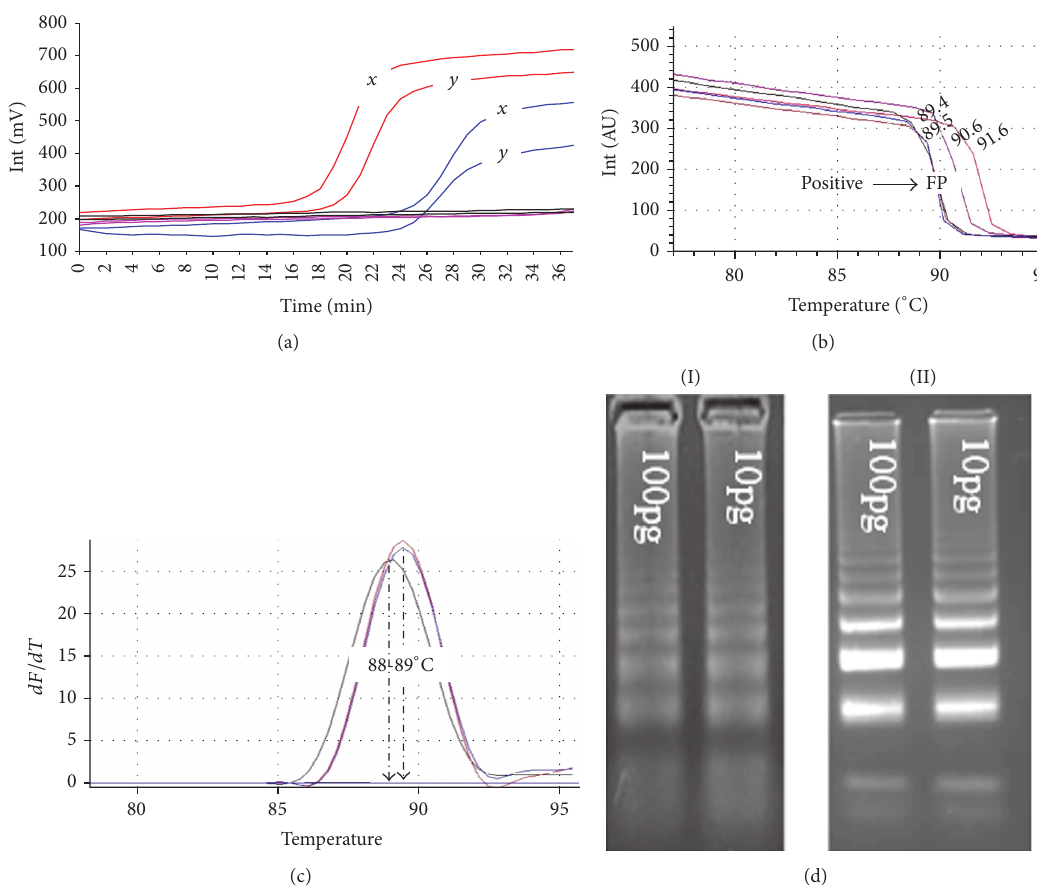
Figure 2: (a) The tube scanner fluorometric output of stem LAMP (red) and standard LAMP (blue) tests using ∼ 10pg of DNA from isolate PT41 ( 𝑥 ) and DNA prepared from CSF ( 𝑦 ) of a confirmed HAT patient. The unit reports the fluorescence in millivolts (mV) on 𝑦 -axis and time in minutes on the 𝑥 -axis. (b) The acquisition of melts curves for PT41, DNA prepared from CSF, and supernatant prepared from a tsetse fly sample spiked with B014 DNA. 𝑇 𝑚 was 89.5 ∘ C for PT41 and DNA from CSF patient and 89.4 ∘ C for B014 in tsetse fly sample. The nonspecific product (FP) is induced for illustration and showed 𝑇 𝑚 that ranged from 72 to 76 ∘ C and 90 to 92 ∘ C (c). The duplication of melts peaks for PT41, CSF, and B014 DNA samples using Rotorgene 6000. The melt peaks showed 𝑇 𝑚 of ∼ 89 ∘ C for PT41 and CSF DNA and ∼ 88 ∘ C for B014. (d) The amplicons for stem LAMP test (I) without outer primers and (II) with outer